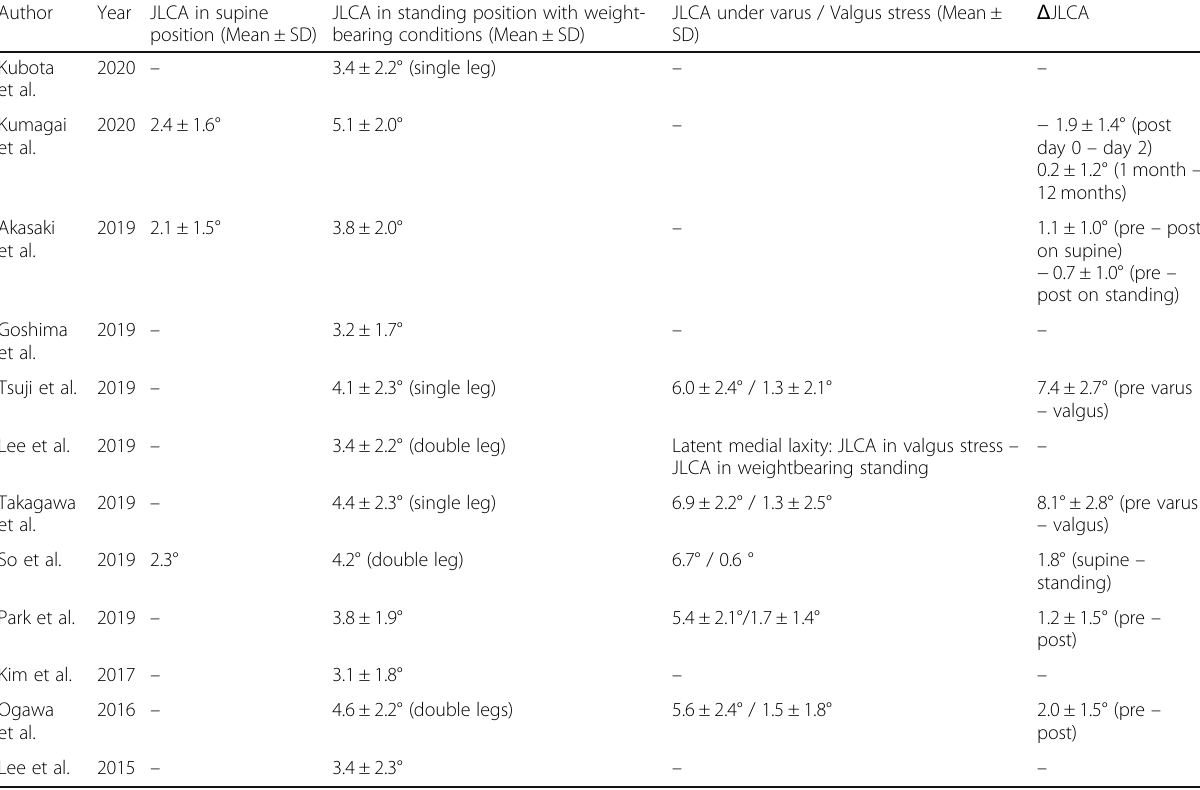
Table 1 Summary of reported evaluation methods for